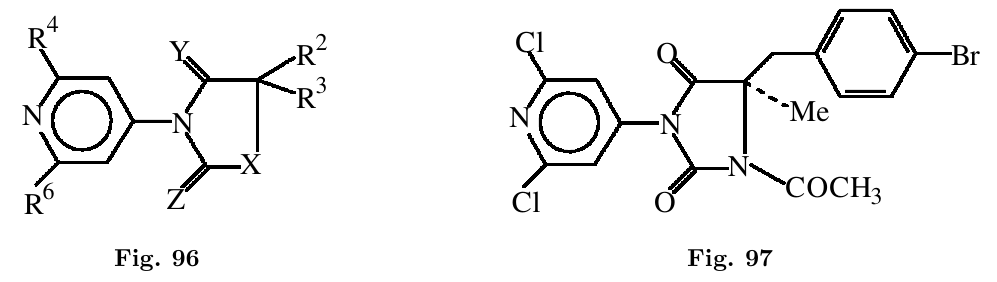
R 2 , R 3 , R 4 , R 6 , X, Y and Z are various